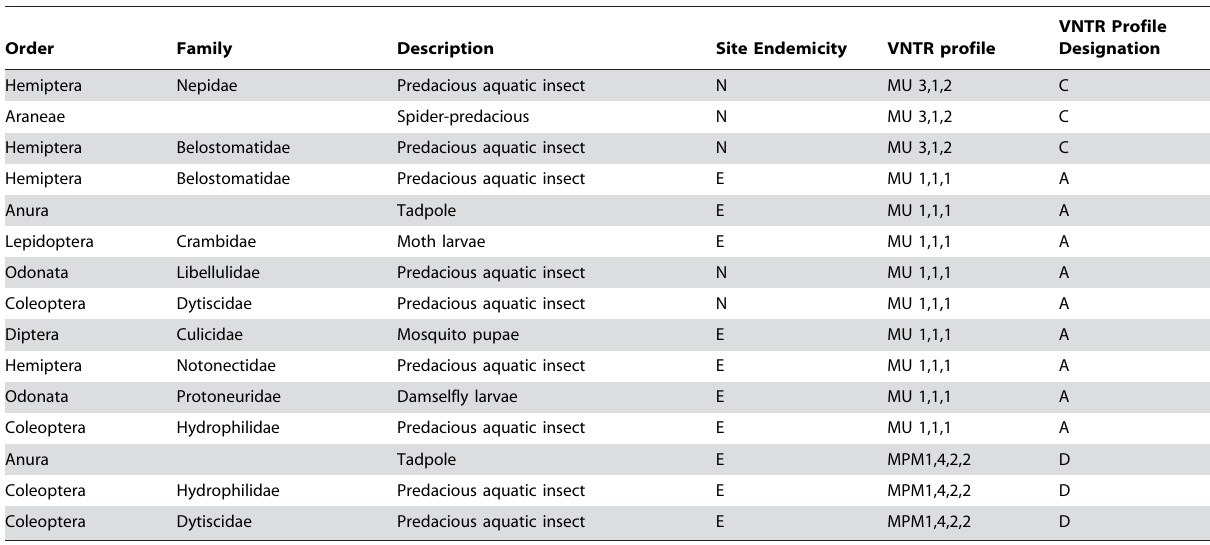
Table 6. VNTR analysis of ER positive